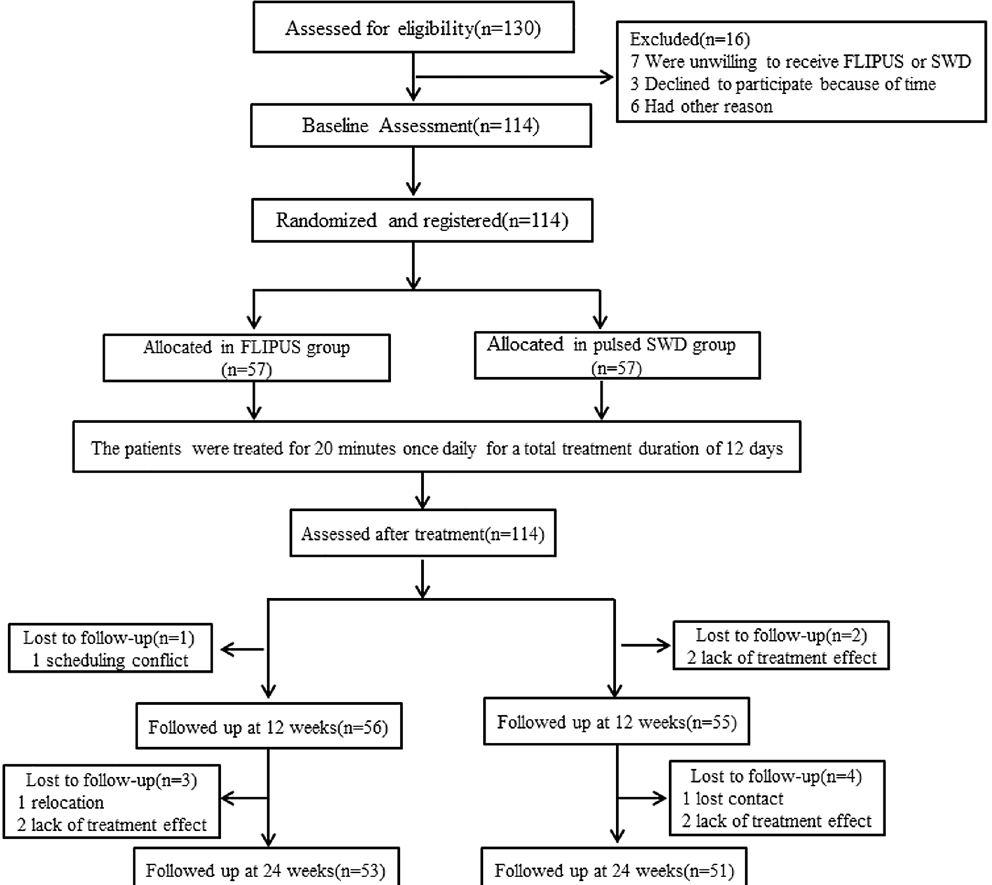
Figure 2. Flowchart of eligible and recruited participants (CONSORT diagram). FLIPUS: focused low-intensity pulsed ultrasound; PSWD: pulsed shortwave